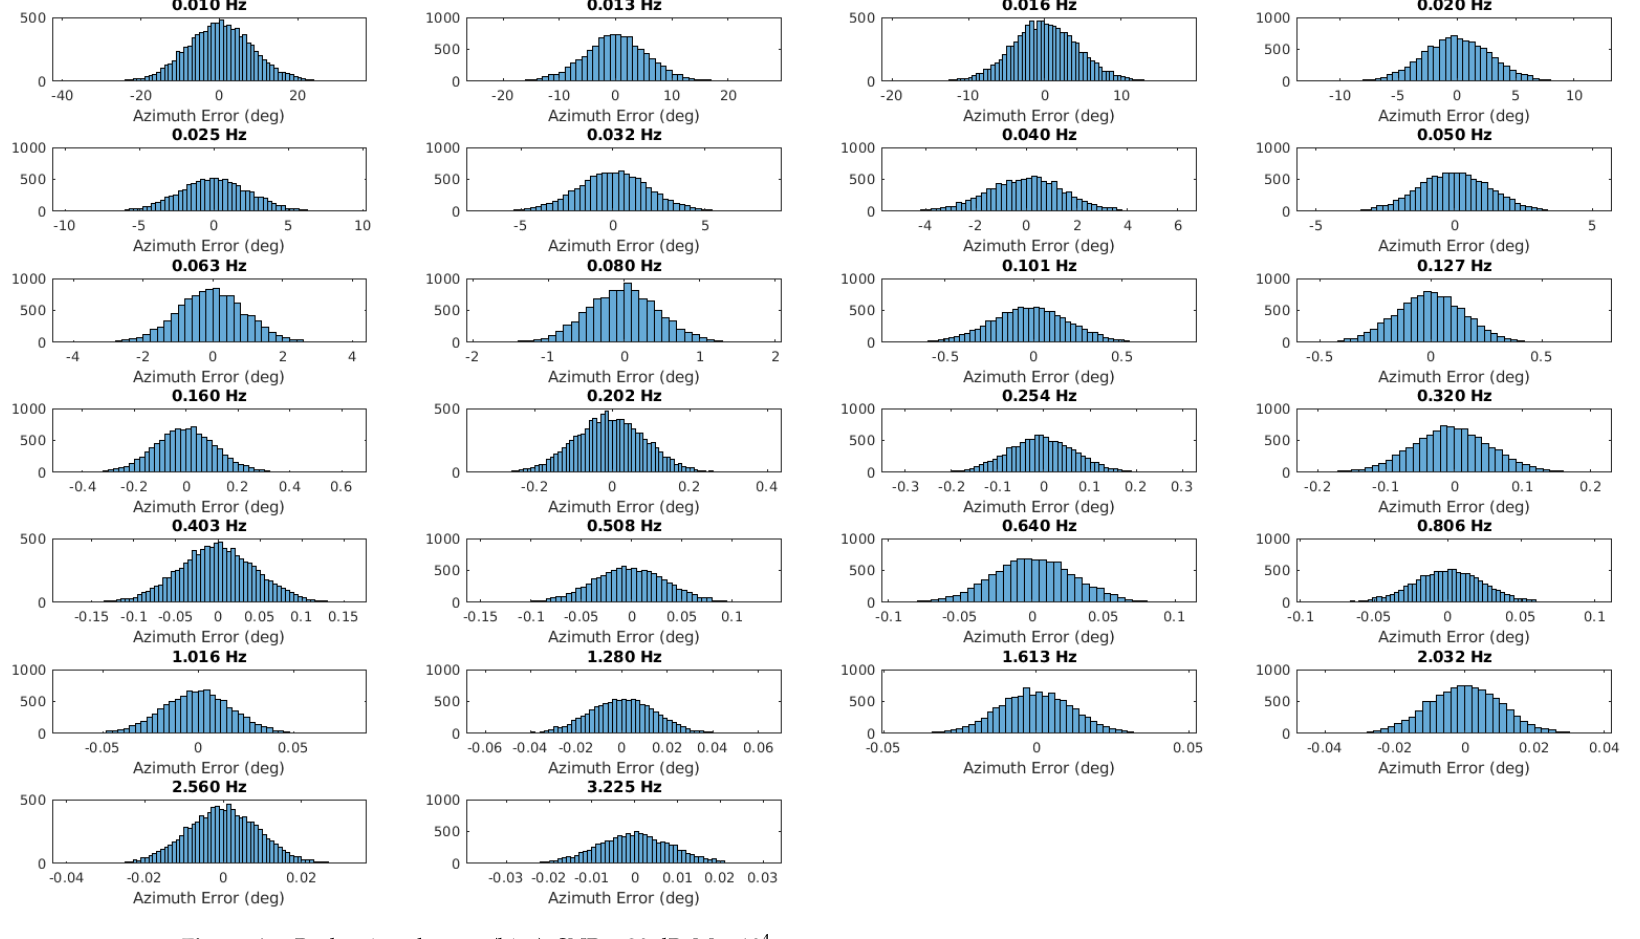
Figure A3. Back azimuth error (bias), SNR = 20 dB, M = 10 4